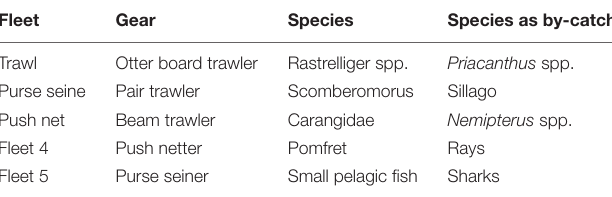
TABLE 3 | Definition of the